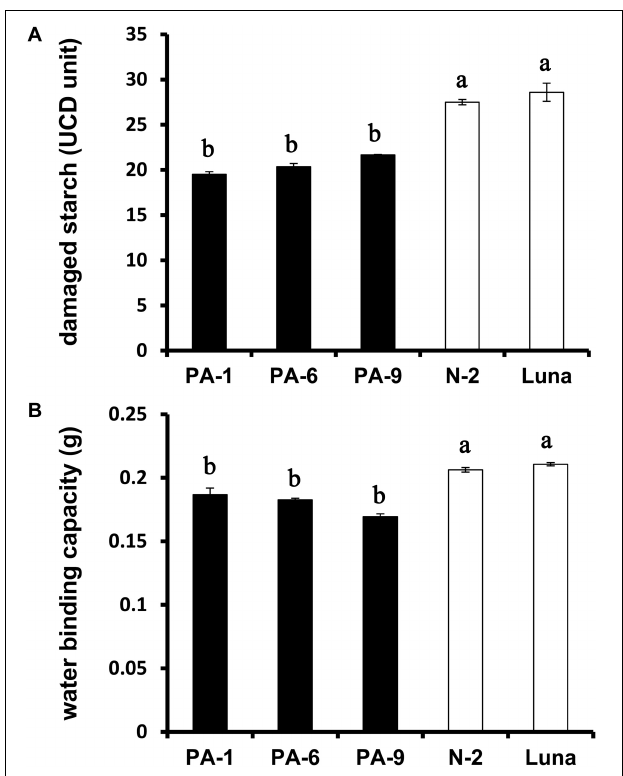
FIGURE 2 | Determination of damaged starch and water-binding capacity of the transgenic and control lines. (A) Damaged starch content and (B) water-binding capacity of wheat flours. Data are provided as mean ± SEM. Damaged starch content and water binding capacity were determined from duplicated samples with triplicate measurements. Values within the column followed by different letters indicate significant difference ( P < 0.05). FIGURE 3 | RVA pasting profile of flour from transgenic lines and control